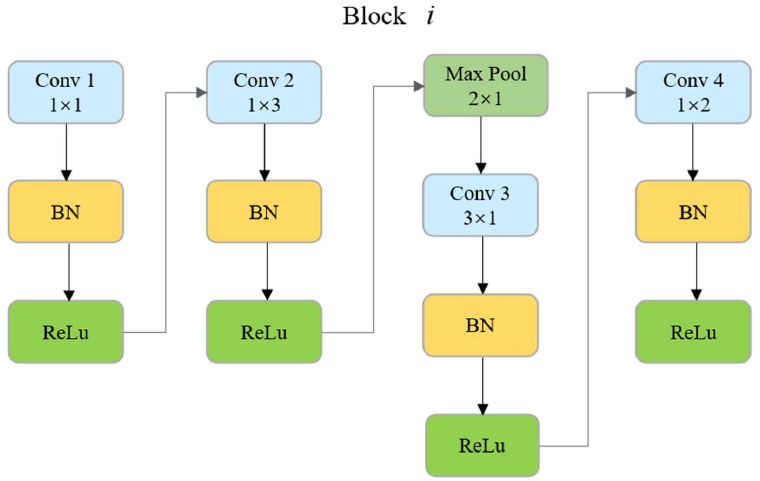
Figure 2. Depth-wise separable convolution block. In block i , the traditional 3 3 deep convolution is decomposed into 1 3 convo- lution kernel Conv2 and 3 1 convolution kernel Conv3, and finally, the feature map X is obtained by 1 2 convolution kernel Conv4.